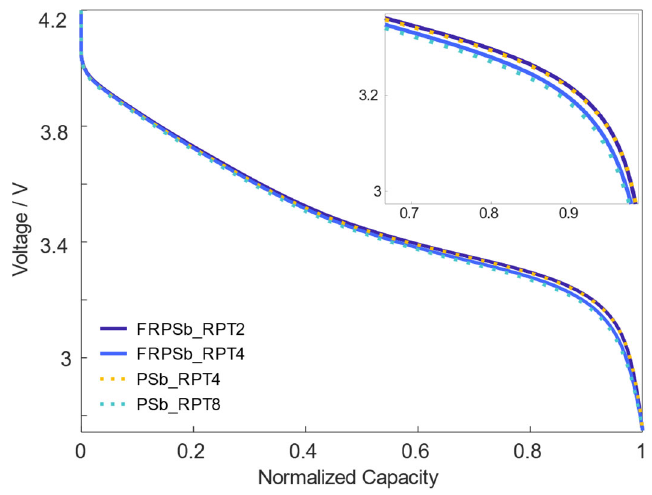
Figure 8. 1C discharge curves for the FRPSb cell and PSb cell with normalized